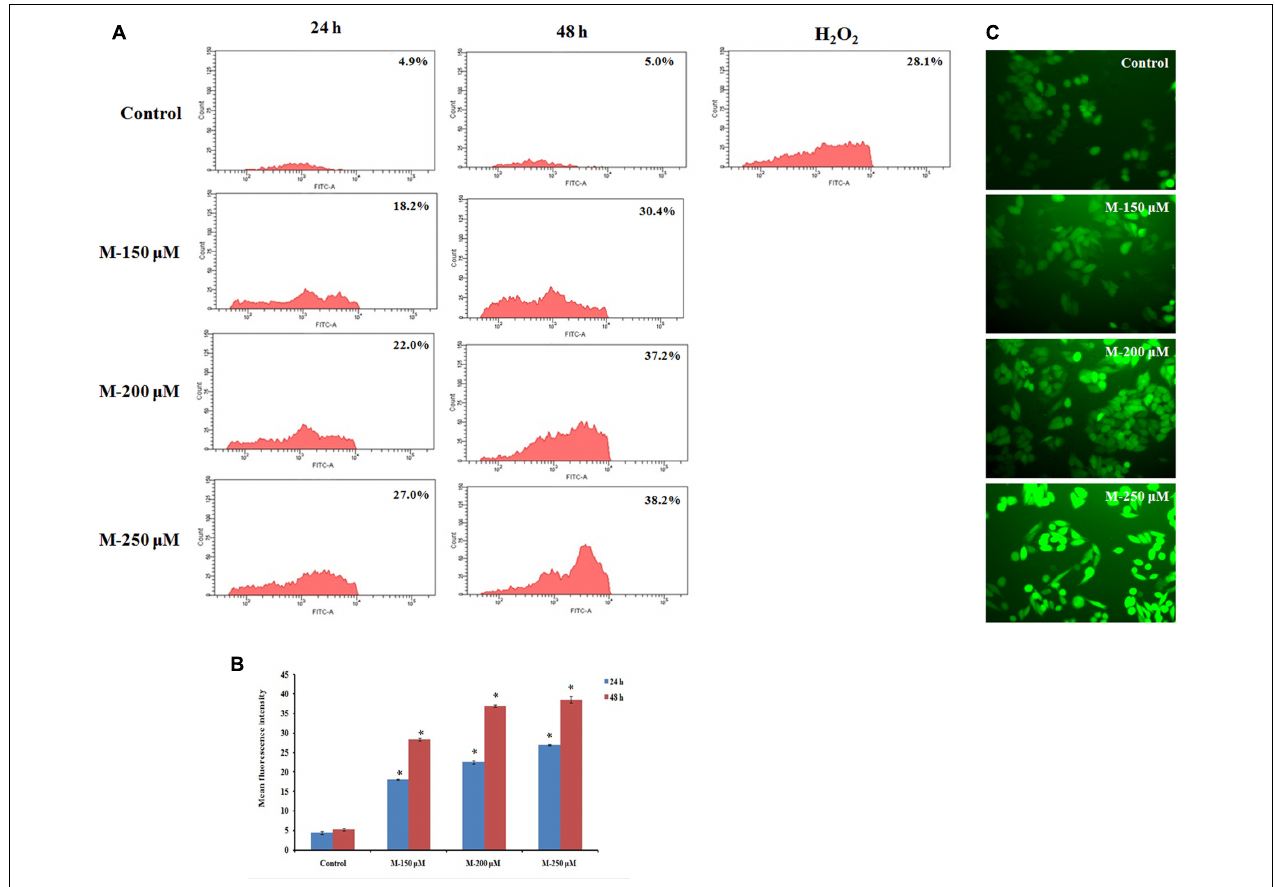
FIGURE 7 | Quantification of ROS formation by DCFH-DA staining. SW480 cells were treated with various concentrations of morin (150, 200, and 250 µ M) for 24 and 48 h and H 2 O 2 (200 µ M) for 2 h. After incubation, cells were stained with DCFH-DA and analyzed using flow cytometer. (A) Representative results. (B) Data analyzing fluorescence intensity from triplicate measurements. (C) Fluorescent imaging using fluorescent microscope. M (150, 200, and 250 µ M): Morin (150, 200, and 250 µ M). Significance levels between different groups were determined by using one way ANOVA, followed by Duncan’s multiple range test. ∗ p ≤ 0.05 versus control.